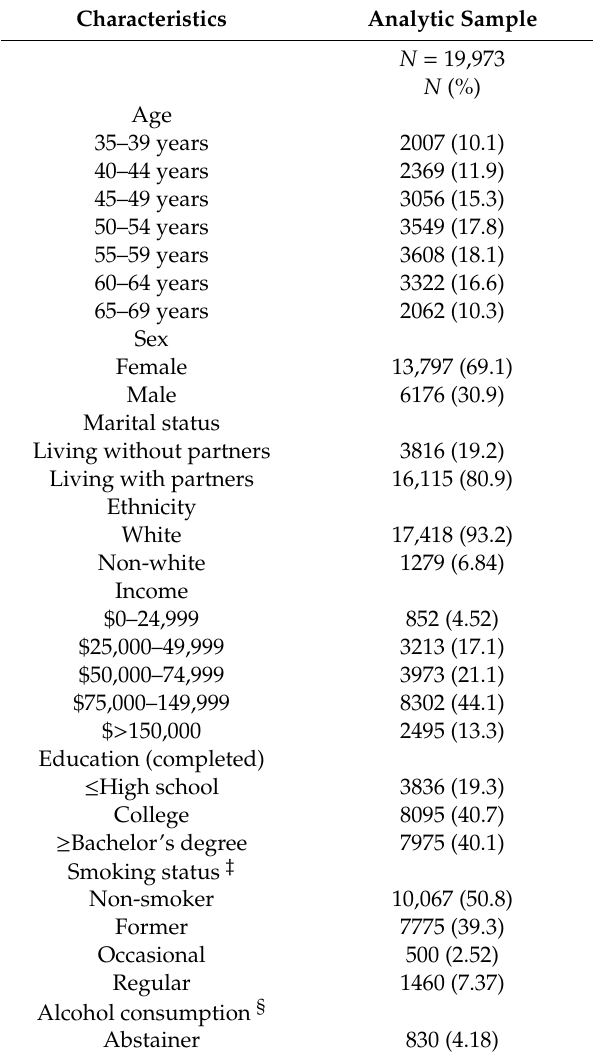
Table 1. Characteristics of the analytic sample from the Atlantic PATH